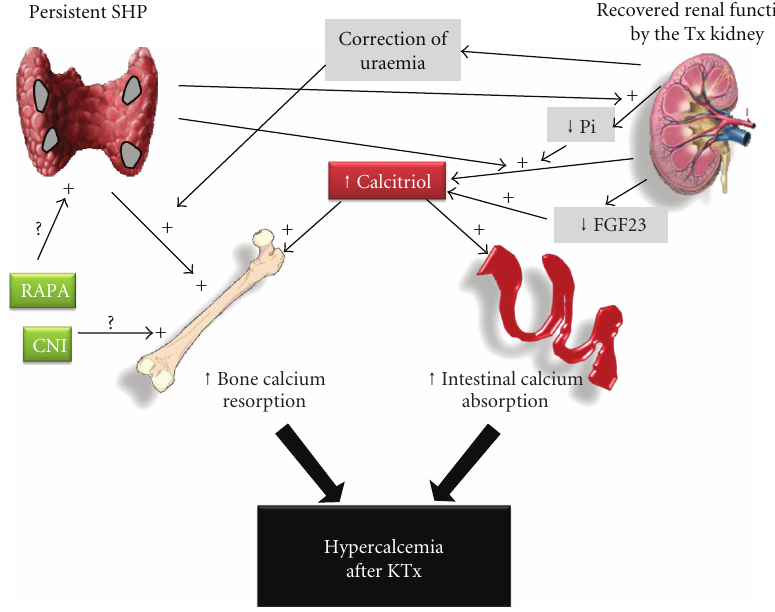
Figure 1: The main supposed mechanisms responsible for the occurrence of hypercalcemia after kidney transplant. (Pi: inorganic phosphorus; CNI: calcineurin inhibitors; RAPA: rapamycin; FGF23: fibroblast growth factor 23).